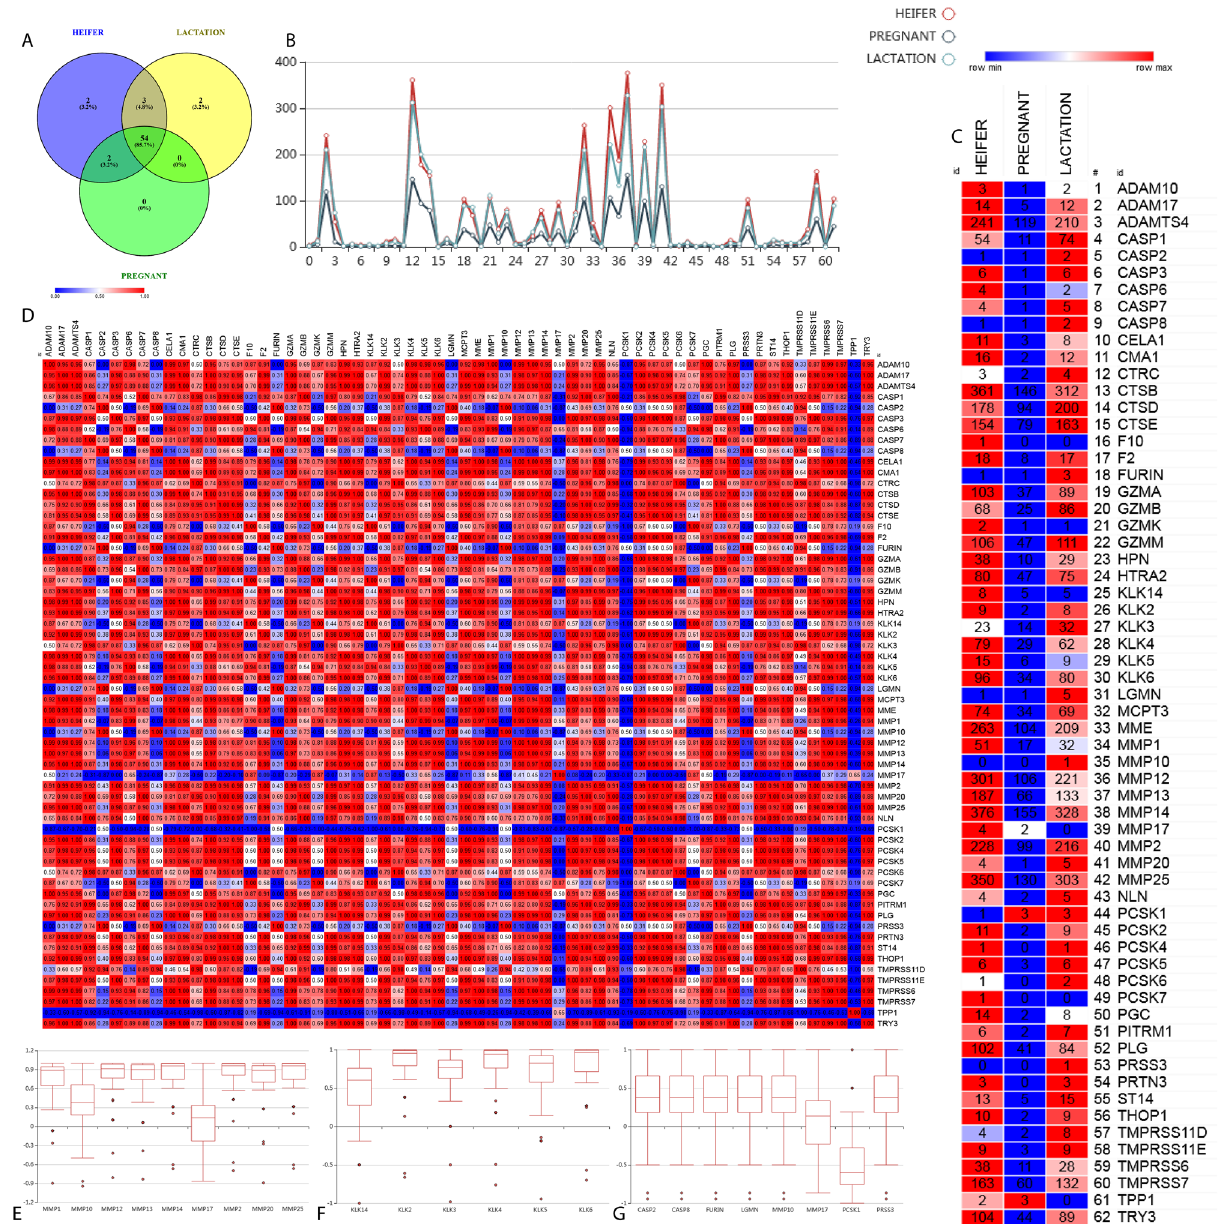
Figure 4. Degradome Analysis: ( A ) Venn Diagram describing the common and unique protease enzyme identified among the stages in the protein data mapping. ( B ) Profile plot depicting the quantitative values of target proteins (Y-axis) map to 62 different protease enzymes (X-axis). ( C ) Quantitative heat map presenting the protease enzyme class with the respective target number in three conditions. ( D ) Pearson correlation- based similarity matrix plot of all protease enzymes and quantitative target relationship. ( E ) Distribution of isoforms of MMP enzymes identified in protein mapping and respective target determined in peptidome. ( F ) Distribution of isoforms of KLK enzymes isoforms identified in protein mapping and respective target determined in peptidome. ( G ) Protease wise comparison for Pearson correlation of 8 different enzyme (CASP2, CASP8, FURIN, LGMN, MMP10, MMP17, PCSK1, and PRSS3) in disagreement with physiological state and uncorrelated with one